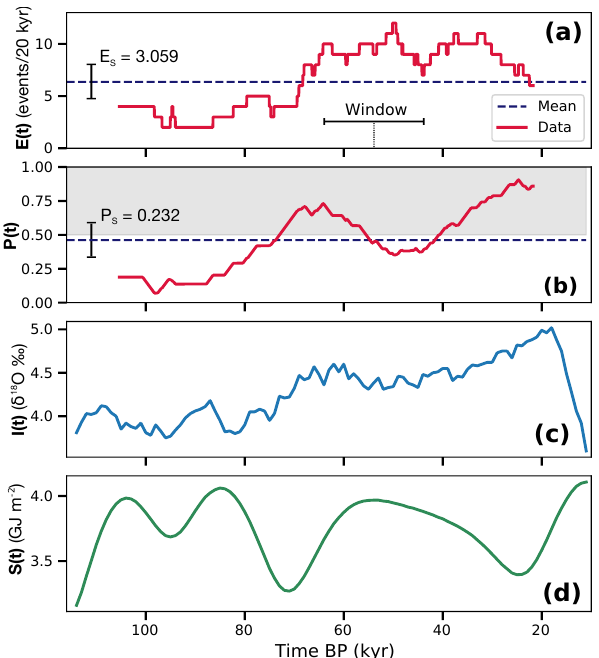
Figure 2. Time-varying irregularity indicators calculated from the NGRIP DO sequence, and climate forcings. (a) The number of warming events in a running 20kyr window E ( t ) (red) and the mean value (dashed blue). (b) The abundance of stadials in a 20kyr window P ( t ). For values greater than 0.5 (indicated by gray shad- ing) the portion of stadials is larger than the portion of interstadials within the window. (c) Ocean sediment proxy record for global ice volume I ( t ). (d) Integrated summer insolation at 65 ◦ N S ( t